Question: What direction does the quantity move in — increasing or decreasing?
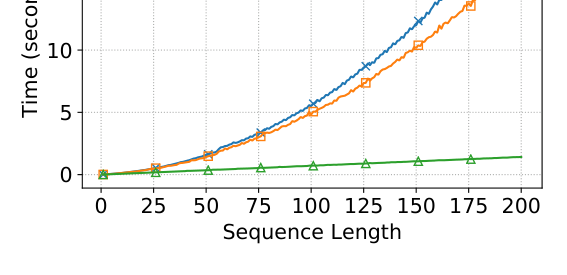
Answer: increasing